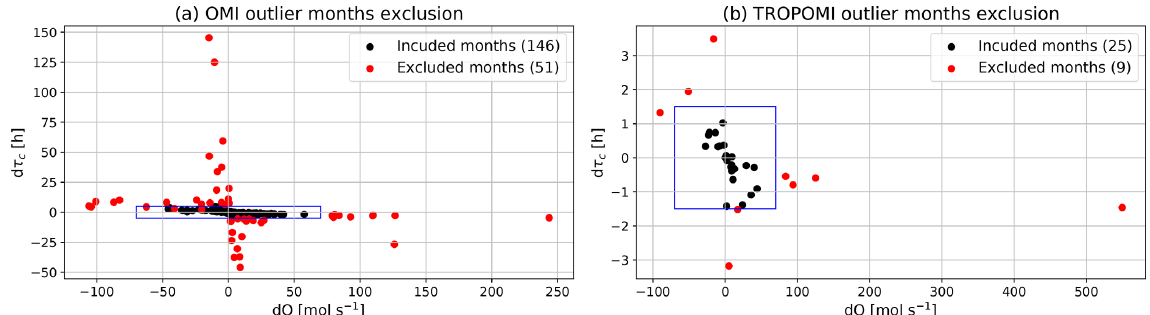
Figure 5. Exclusion of outlier months (red) for OMI (a) and TROPOMI. Each dot locates the differences of Q and τ c from the corresponding climatological month fitting with and without a specific calendar month. The blue boxes show the boundaries delineating the maximum tolerated Q and τ c influences from each calendar month to their corresponding climatological